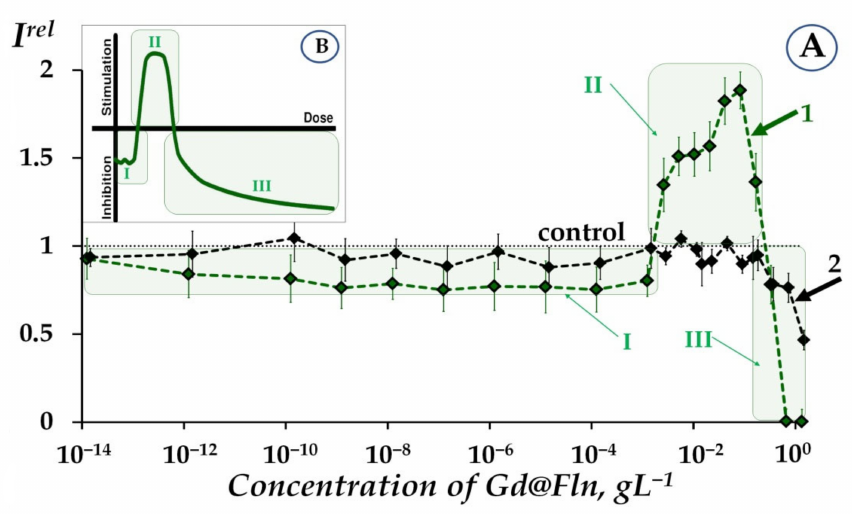
Figure 1. ( A ) Relative bioluminescence intensity, I rel , at different concentrations of fullerenol Gd@Fln in bacterial suspension (1) and enzymatic system (2). The 5-min exposure. ( B ). Scheme of hormesis dose-effect model is presented according to [67]. Hormetic stages: I—stress recognition, II—physiological activation, III—inhibition of vital functions. “Control” corresponds to the absence of Gd@Fln in the experimental